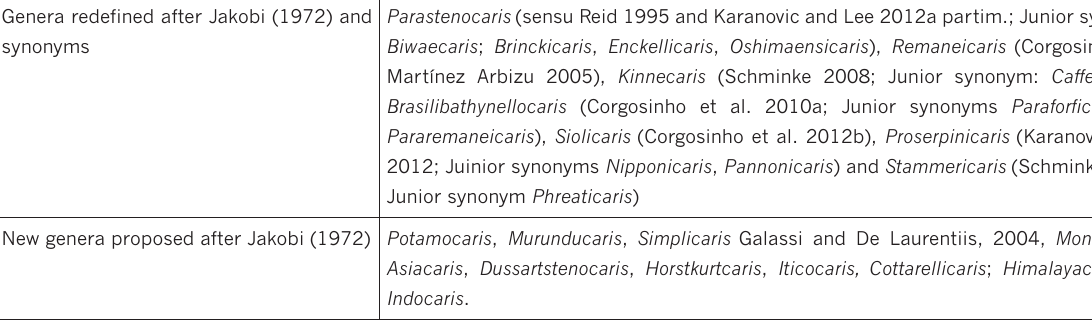
Table 2. List of genera redefined after Jakobi (1972) followed by the respective synonyms and genera proposed after Jakobi (1972). Genera redefined after Jakobi (1972) and